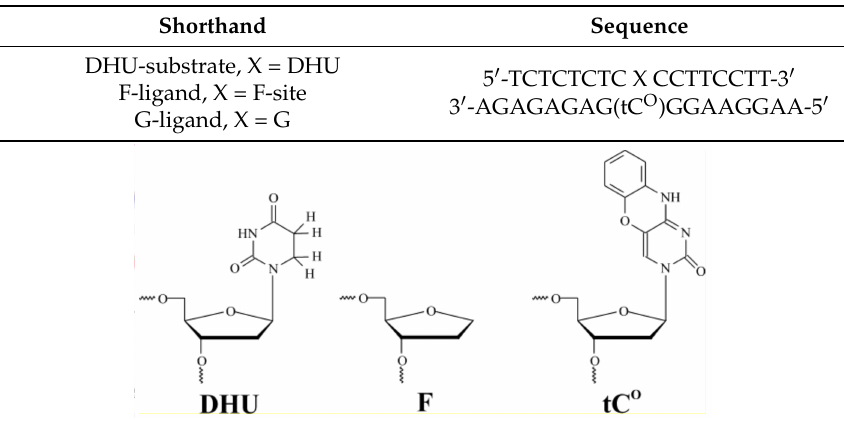
Table 1. DNA duplexes used as substrates and ligands of Endo III. DHU: 5,6-dihydrouracil; F: (3-hydroxytetrahydrofuran-2-yl)methyl